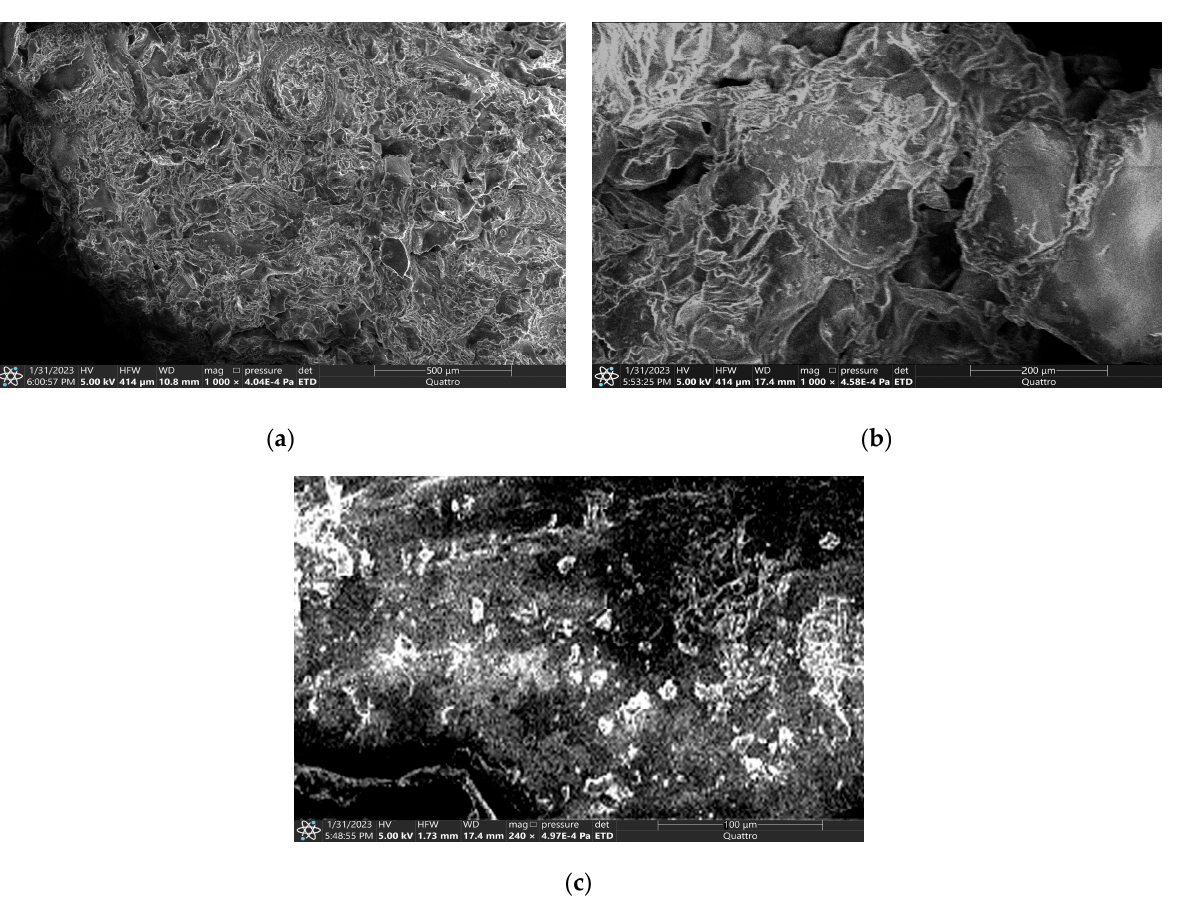
Figure 3 . SEM images of the surfaces: ( a ) Rh; ( b ) Rh bio ; ( с ) Rh bio –Mt.